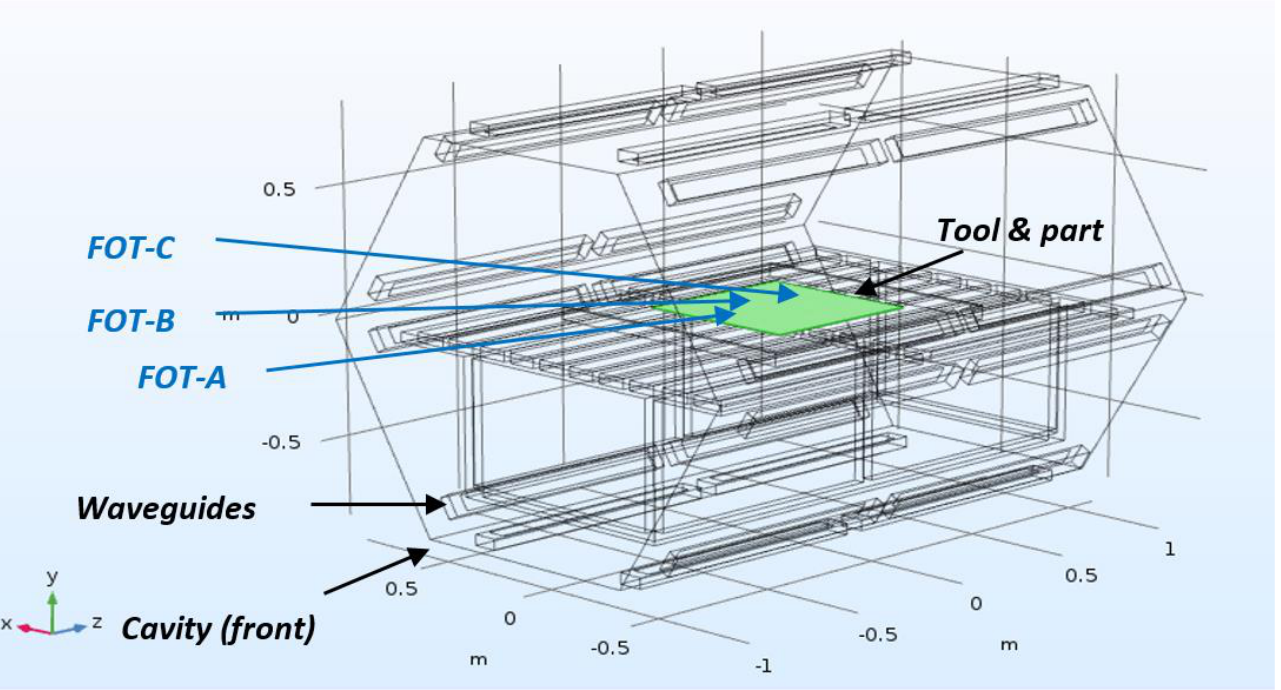
Figure 1. Schematic illustration of the Vötsch microwave with the tool and part in the centre of the cavity [13].